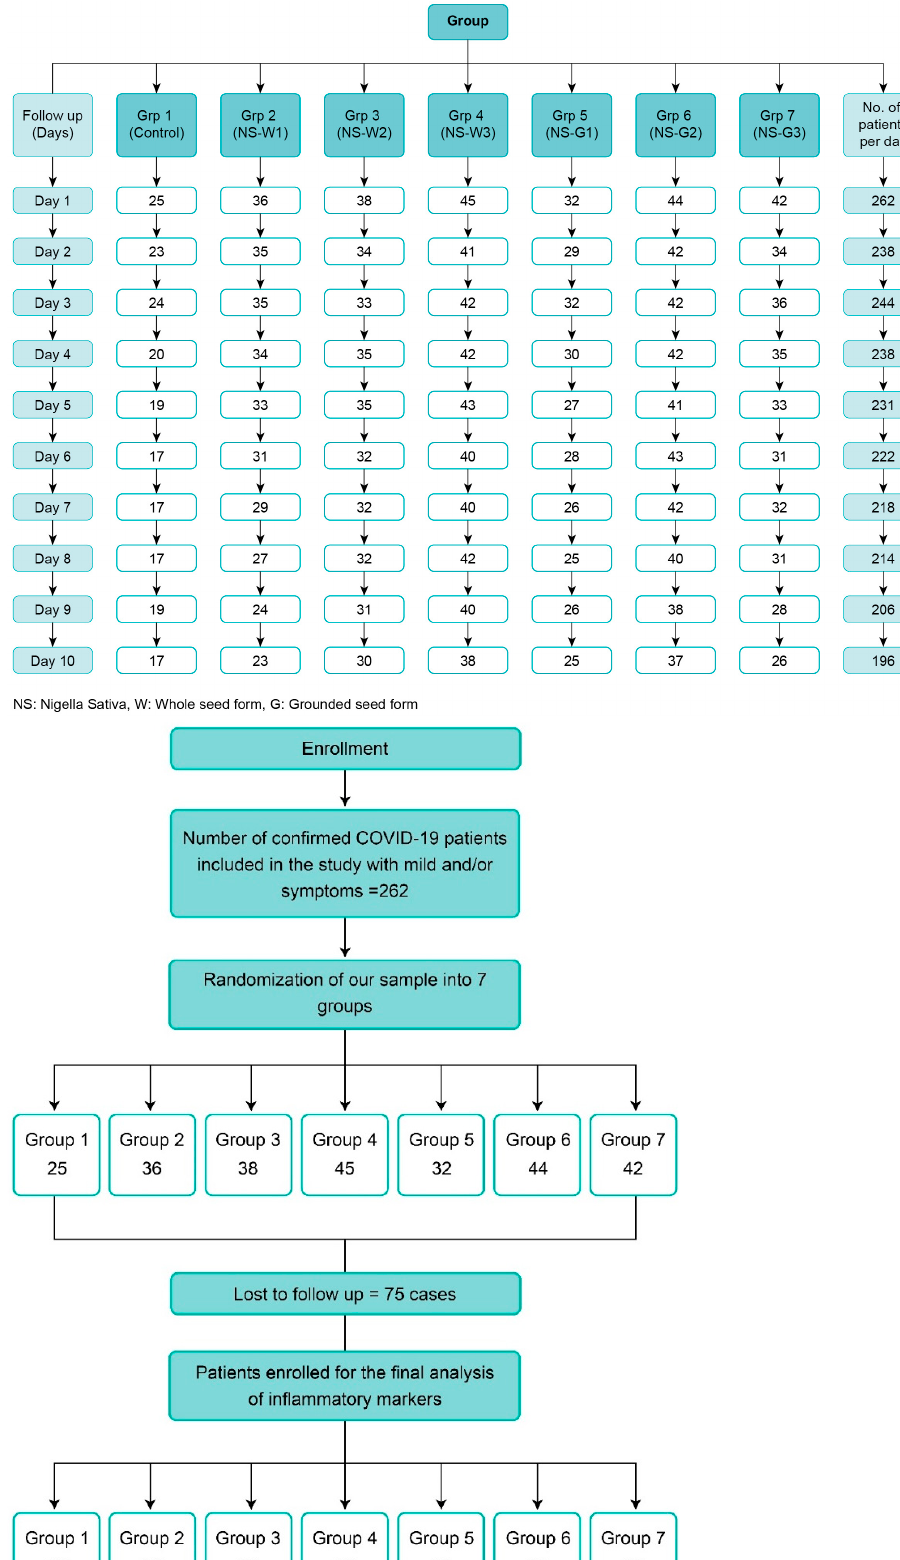
Figure 1. The distribution of patients in the seven groups, randomization, loss to follow-up, and analysis